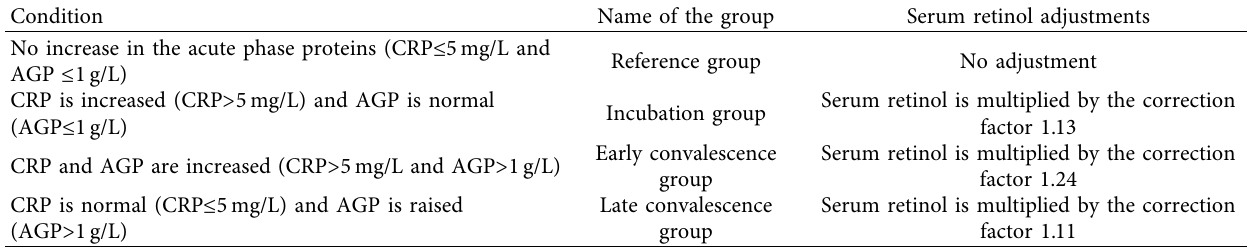
Table 1: Infammation adjustments done to obtain serum retinol adjusted values.